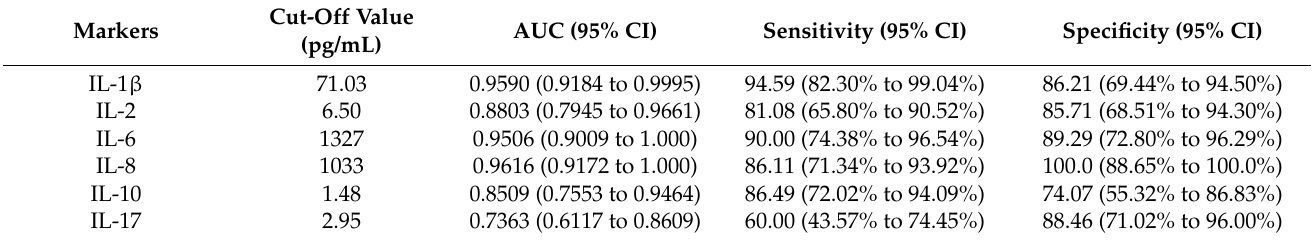
Table 2. Sensitivity and Specificity of inflammatory markers.